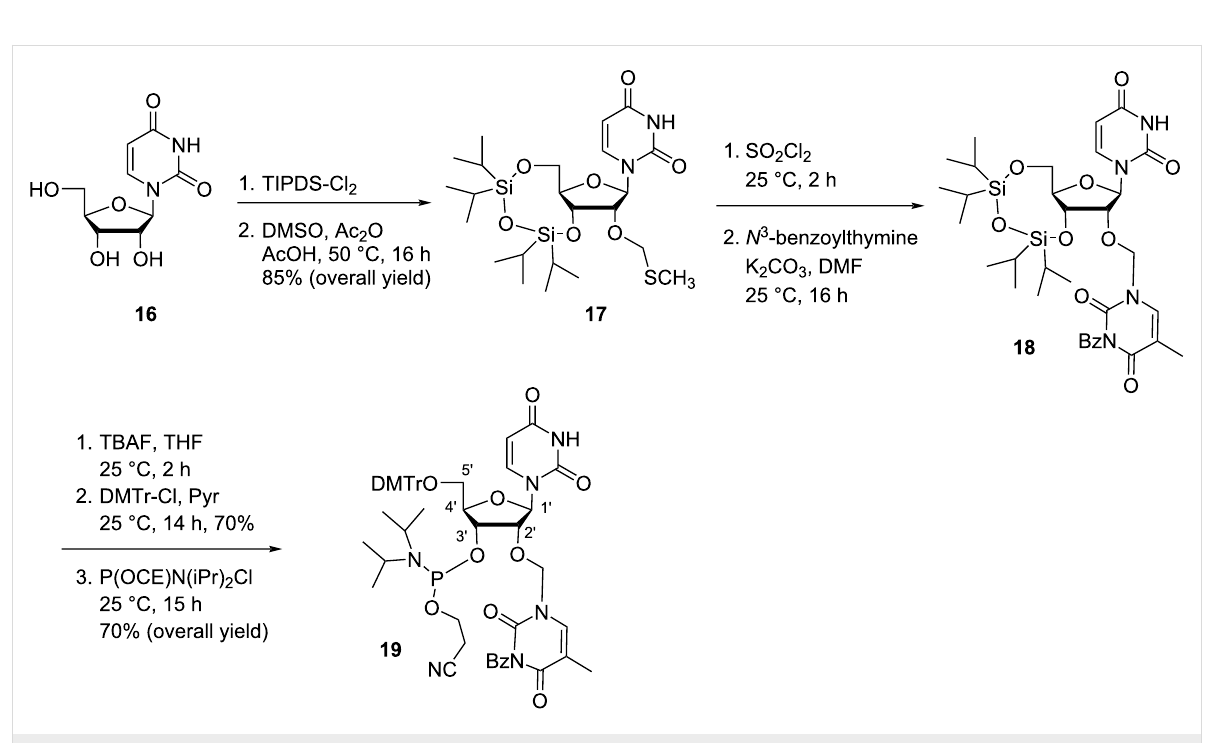
Scheme 5: Synthesis of the double-headed nucleoside 19 .